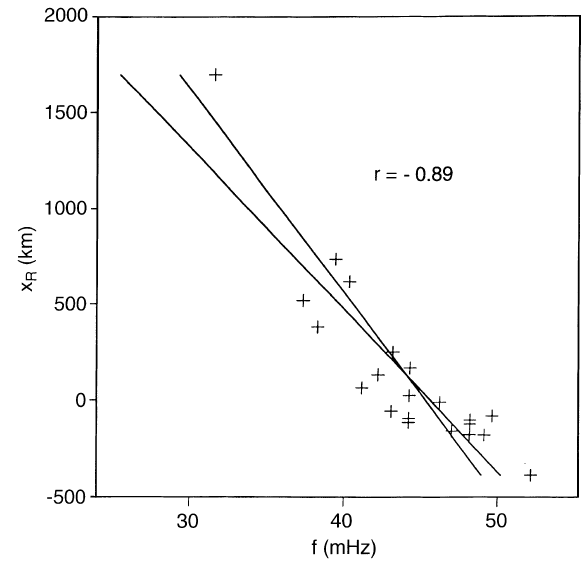
Fig. 3. Range finding at the latitude 43 : 9 (cid:14) on August